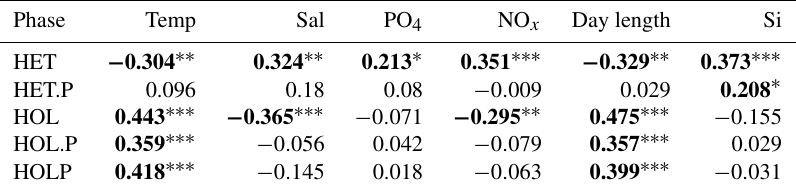
Table 7. Spearman correlations for the Mediterranean data set. Phase Temp Sal PO 4 NO x Day length Si HET − 0.304 ∗∗